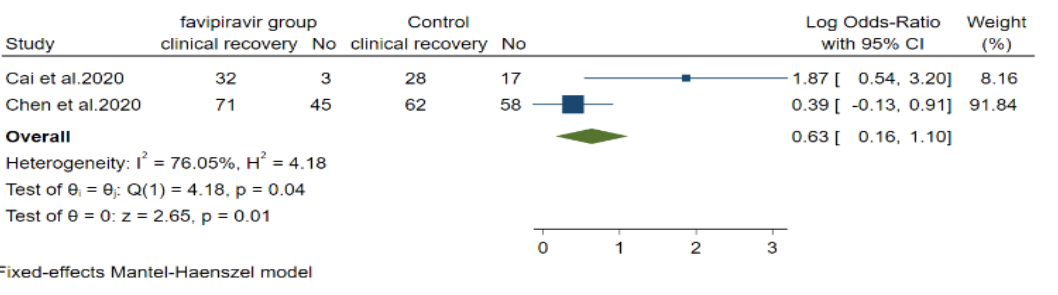
Figure 2. The odds ratio of Improvement rates between the experimental group (Favipiravir) and control group